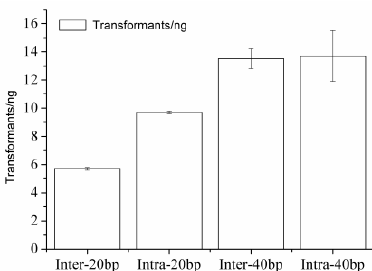
Figure 4. Comparing the ExnaseII cloning with the intra-HR. Intra-20 bp, -40 bp: transformant efficiency of intra-HR-for DNAs having 20 bp or 40 bp homology arms, inter-20 bp, -40 bp: transformant efficiency of ExnaseII cloning-for DNAs having 20 bp or 40 bp homology arms.